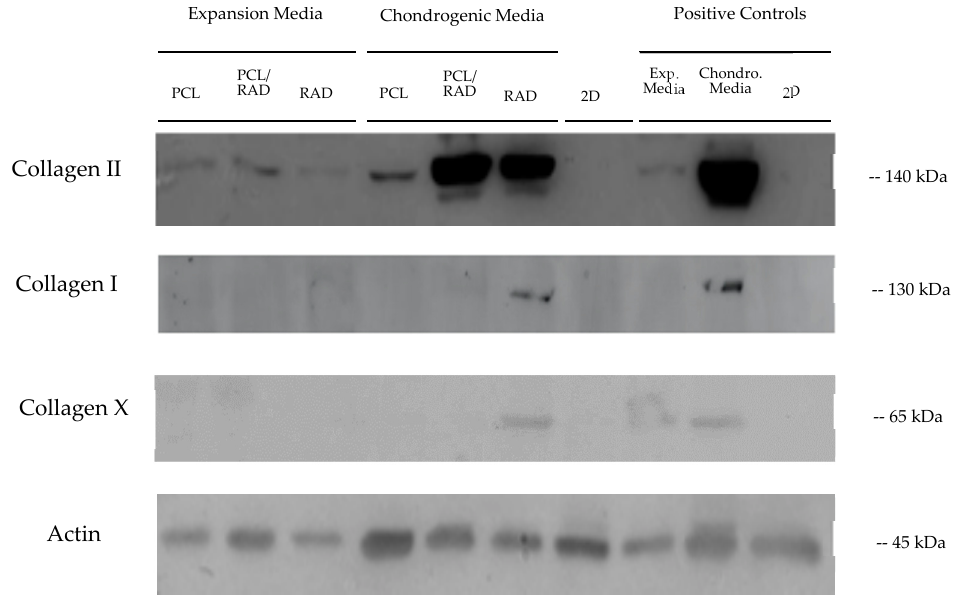
Figure 6. Western Blot results from the human mesenchymal stem cells (hMSCs) assay after 30 days of culture. The expression of three chondrogenic and hypertrophic markers was analyzed in expansion and chondrogenic media, in 2D, and in positive control samples. Actin was used as a control protein. Representative image obtained from two different blots. n = 3.